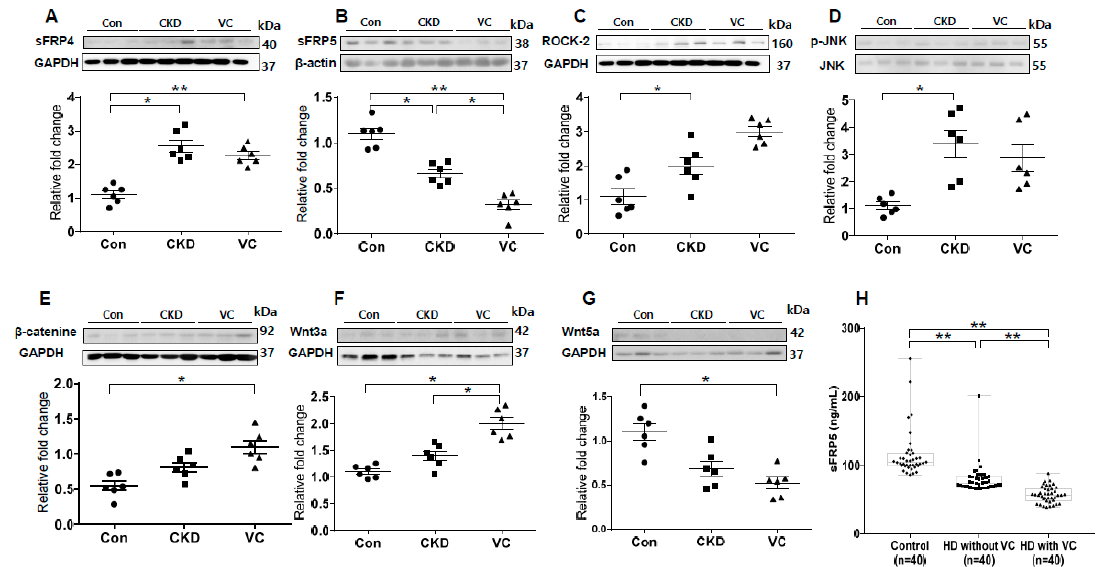
Figure 7. Expression of secreted frizzled-related proteins (sFRPs) and Wnt signaling in an animal model of adenine-induced chronic kidney disease (CKD) were measured by Western blotting, and serum concentrations of sFRP5 were measured in human subjects. For each model, six rats were included; three representative results from each group are presented. The expression of sFRP4 was increased ( A ) and that of sFRP5 was decreased ( B ) in the CKD with vascular calcification (VC) group compared with the control group. The expression levels of ROCK-2 ( C ) and phosphorylation of JNK ( D ) were significantly increased in the CKD group compared with the control group. The expression of β -catenin ( E ) and Wnt3a ( F ) was significantly increased and that of Wnt5a ( G ) was decreased in the CKD with VC group compared with the control group. ( H ) The serum concentration of sFPR5 was significantly lower in patients on hemodialysis (HD) than in subjects with normal renal function. Among patients on HD, subjects with VC had significantly lower levels of serum sFRP5 than did subjects without VC. Three representative samples per group are shown ( A – G ). Data are expressed as means ± standard errors of the means from six samples per group. * p < 0.05, ** p < 0.01.